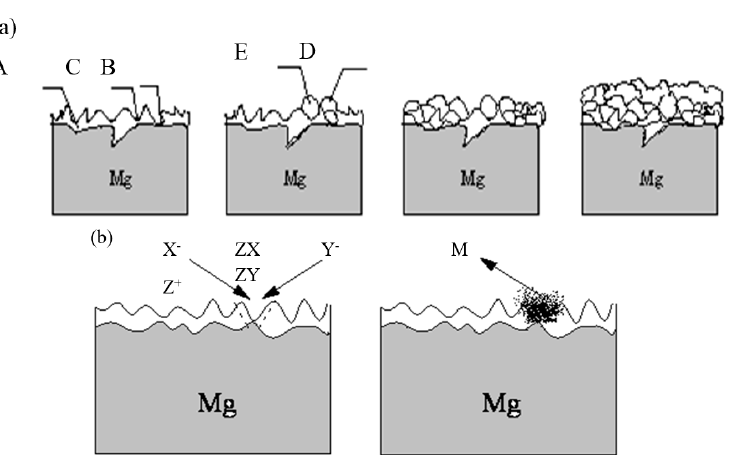
Figure 9. The schematic diagrams of the cross-sections of the molten ceramic membranes. ( a ) A— the surface of the pre-prepared membrane layer; B—the weakest place of the preprepared membrane layer; C—the relatively weak place of the preprepared membrane layer; D—the particles deposited on the weakest place of the membrane layer; E—the particles deposited on the relatively weak place of the membrane layer. ( b ) M—the particles; X − , Y − —the anions in the electrolyte; Z + —the cations in the electrolyte; ZX, ZY—the oxide particles suspended in the electrolyte.